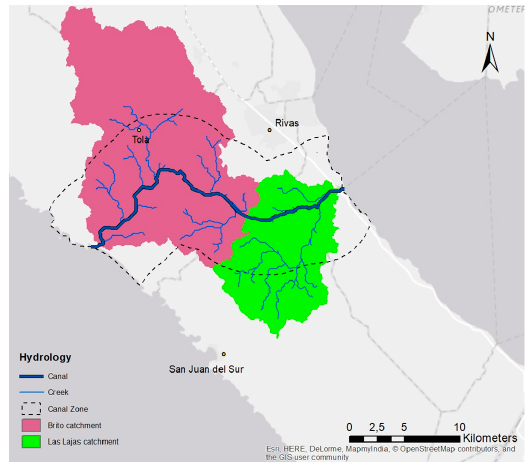
Figure 4. Representation of the river catchments and the stream network supplying the canal.